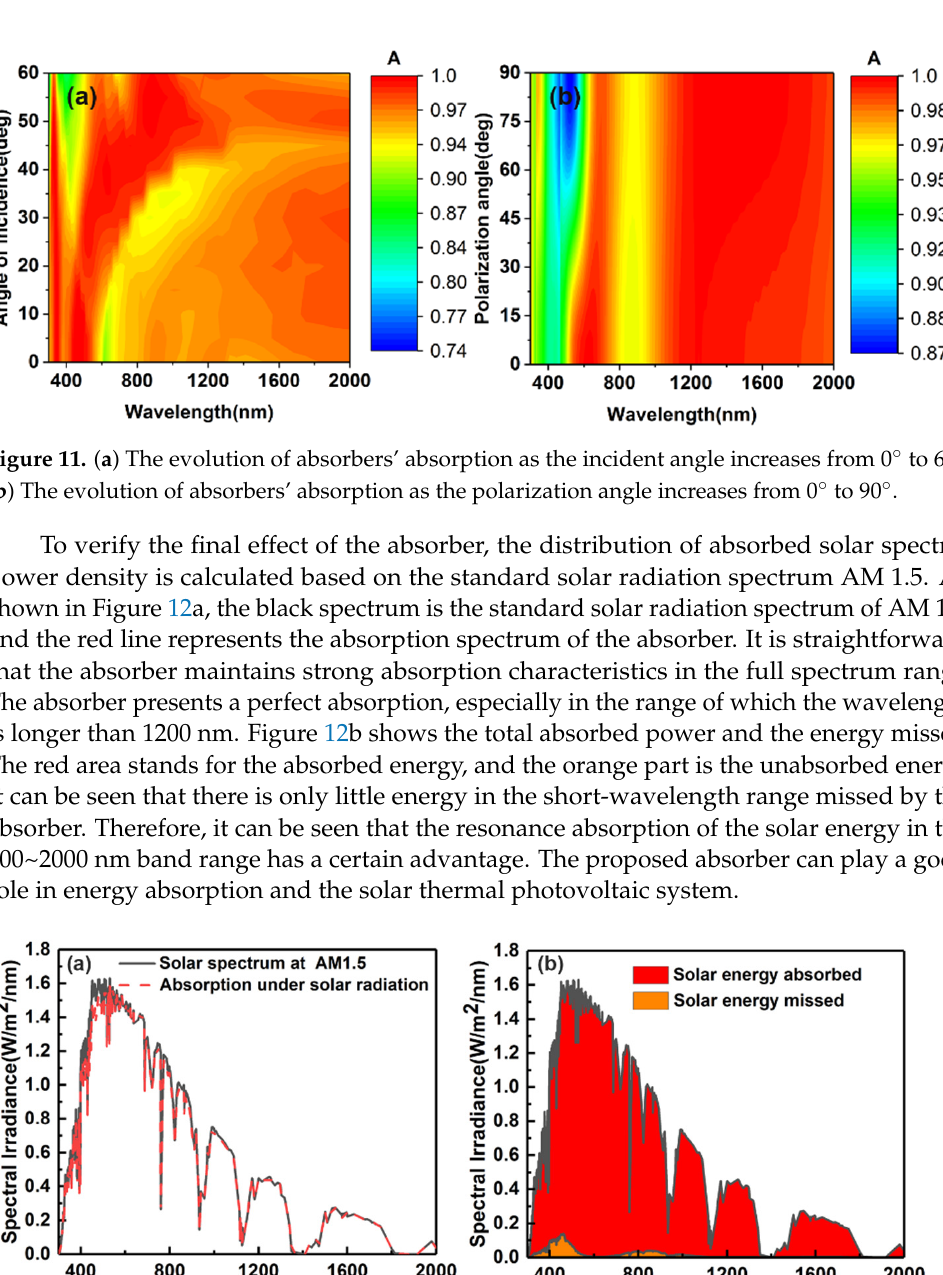
Figure 12. ( a ) Comparison of the AM 1.5 standard spectrum of solar radiation and the absorbed spectrum. ( b ) The energy absorbed and lost by the absorber under AM 1.5.